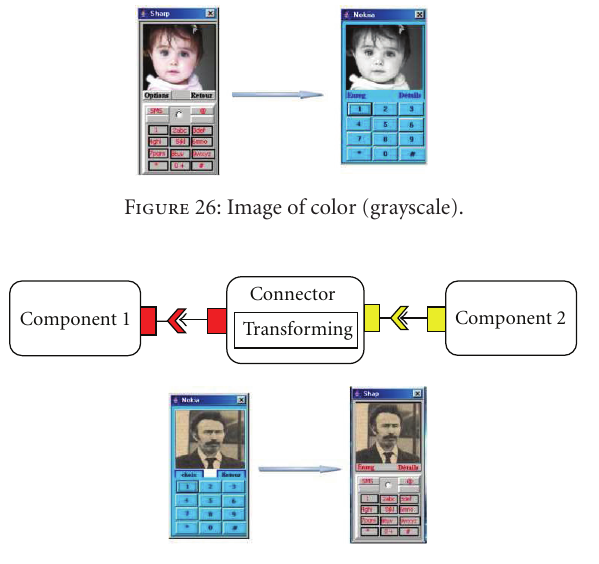
Figure 27: Adaptation of format (JPEG to